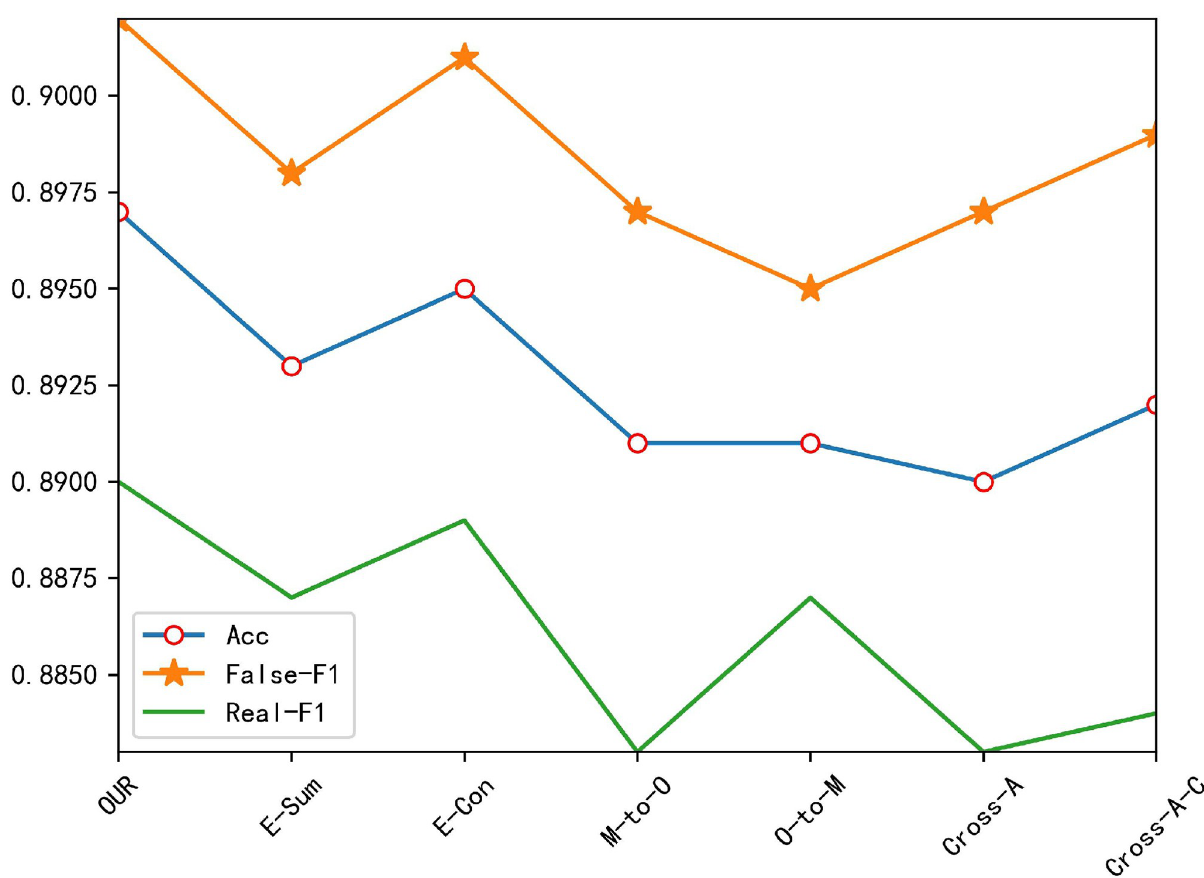
Fig 10. Experimental results of ablation experiment